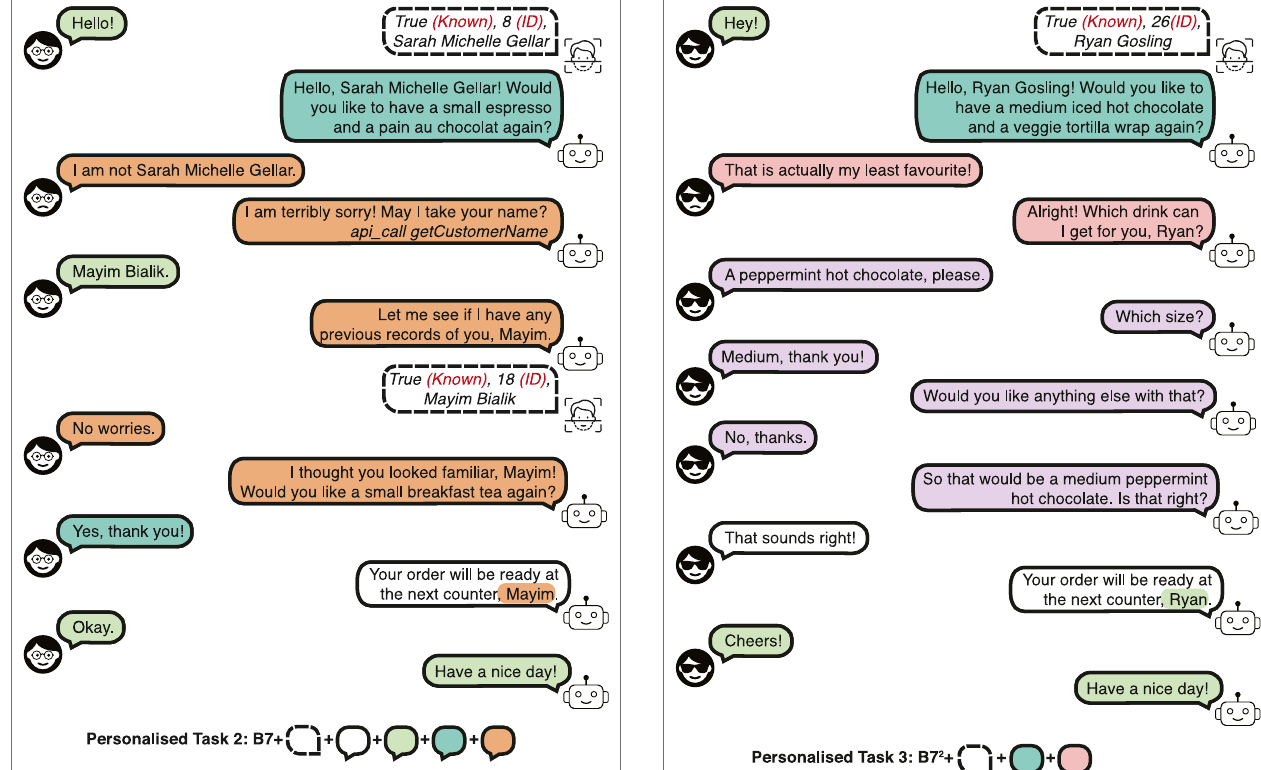
FIGURE3| AdialogueexampleinthePersonalisedBaristaDatasetTask 2 (recognition error). FIGURE4| AdialogueexampleinthePersonalisedBaristaDatasetTask